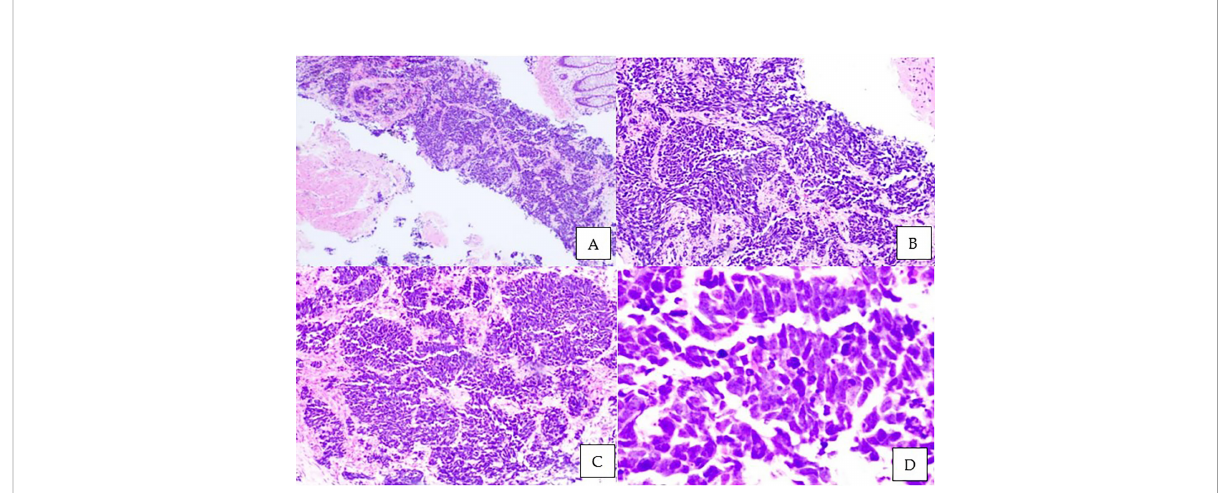
FIGURE 1 Microscopic examination of the prostate biopsy. Sheets and nests of malignant small ovoid cells with intervening stroma and rectal mucosa fl oating in the adjacent area. Tumor cells have minimal cytoplasm, hyperchromatic mildly pleomorphic nuclei with stippled chromatin, nuclear molding with peripheral palisading, brisk mitotic activity, apoptotic cells, and occasional necrosis. No glandular or tubule formation and no obvious vascular invasion. (A) Hematoxylin and eosin staining (H&E), ×40; (B) H&E, ×100; (C) H&E, ×200; (D) H&E